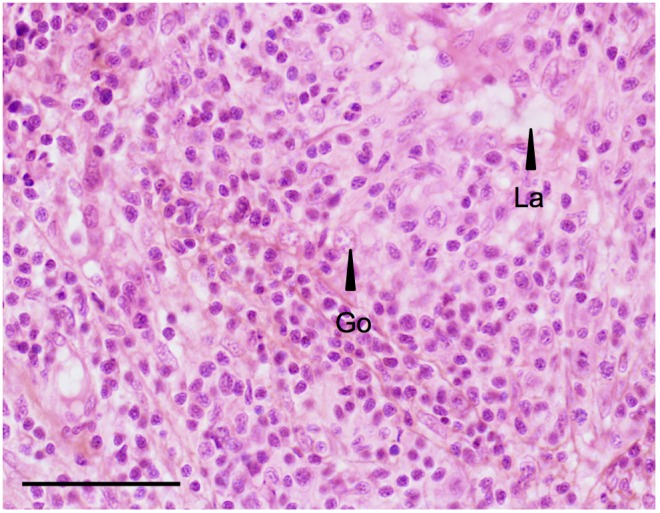
Altered testicular morphology.All-male rainbow trout testis at 136 dpf exposed chronically to 1 µg/L EE2. HES. Scale bar = 50 µm. This picture illustrates the degeneration of the testis observed in several fish exposed to EE2, such as a loss of tubular arrangement, loss of germ cell number (Go) and differentiation, presence of lacuna (La). There is no recognizable differentiation of the gonad into male or female phenotype.